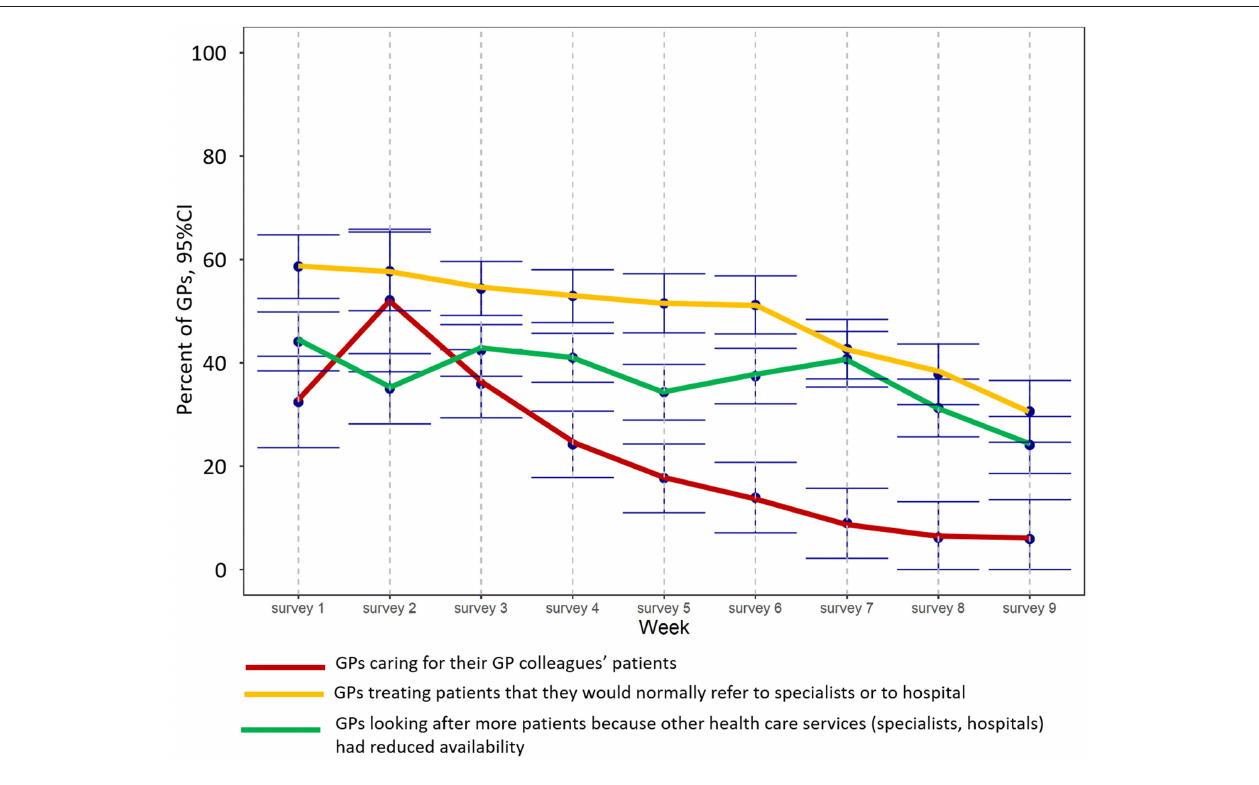
FIGURE 3 | Interaction of GPs with patients during the study period.